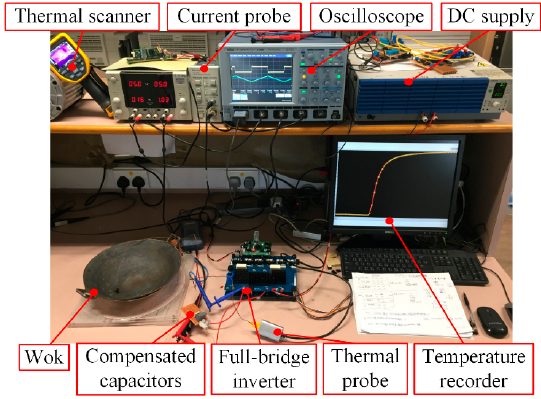
Figure 11. Experimental prototype and testing setup.